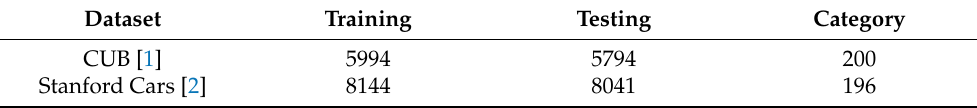
Table 1. Dataset